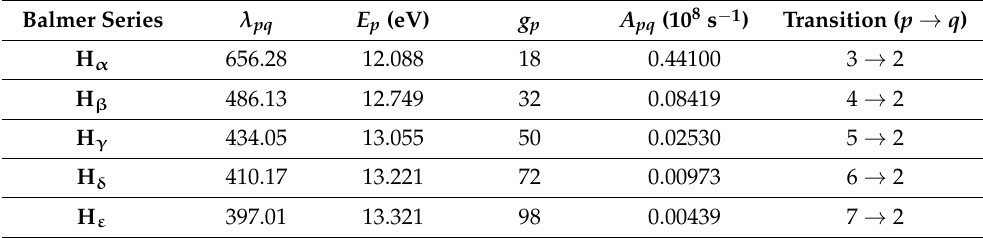
Table 4. Parameters used in the calculation of electron temperature. Balmer